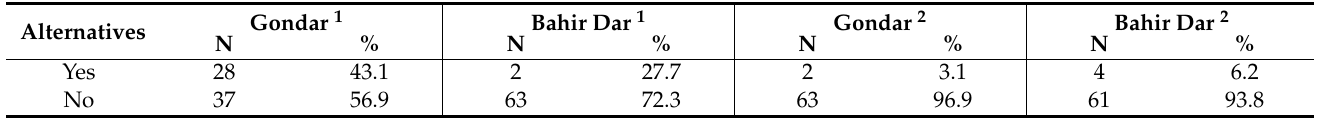
Table 3. Urban infrastructure resiliency to disasters 1 and familiarity of the urban resilience concept in urban planning 2 ( n = 65 each city).